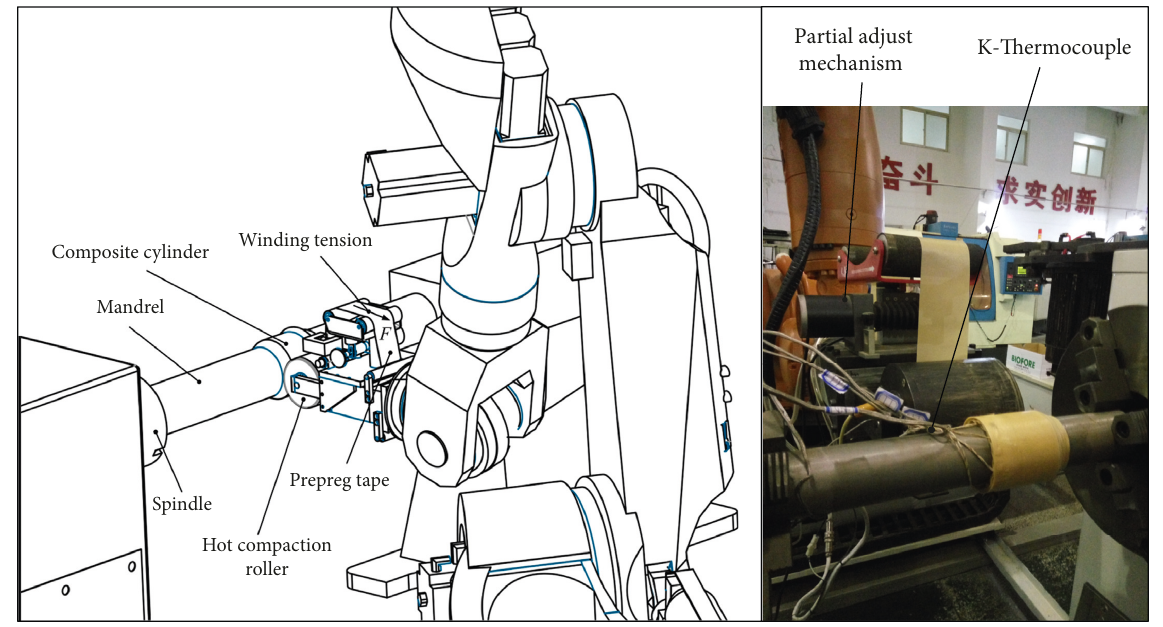
Figure 4: Composite cylinder fabricated by a robotic winding machine.